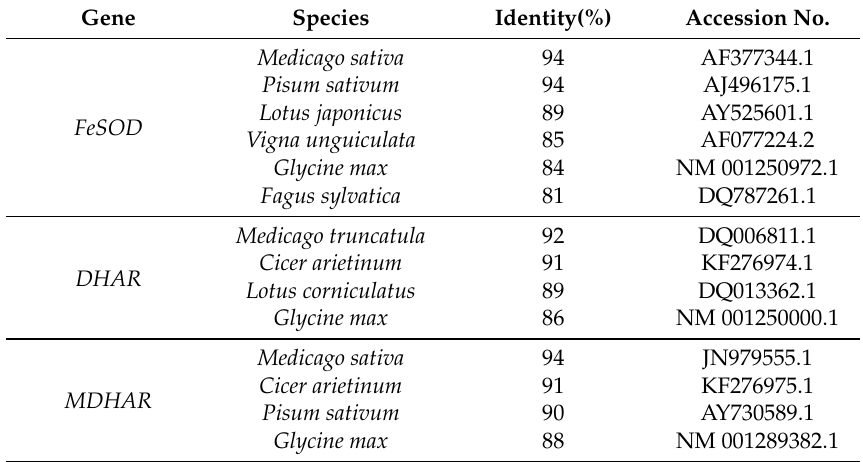
Table 1. The homology of FeSOD , DHAR and MDHAR comparison with other plant species. Gene